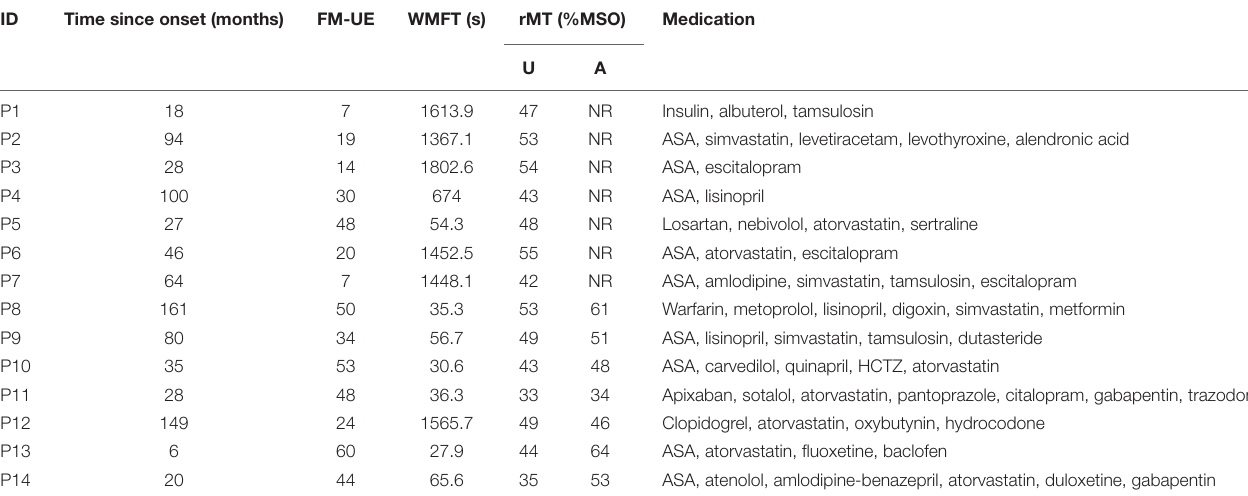
TABLE 1 | Participant characteristics at study